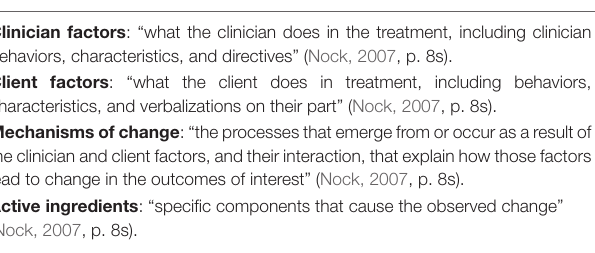
TABLE 2 | Components of psychological